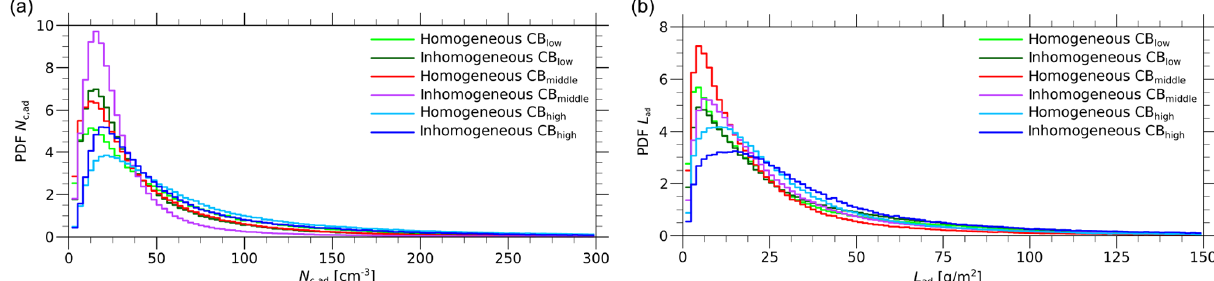
Figure 4. PDFs of the spatio-temporal distribution of 4 years (2007–2010) of MODIS retrievals as reported in the CCCM dataset at the 20km × 20km horizontal resolution at nadir below the A-Train satellite constellation, between 60 ◦ S and 60 ◦ N. Liquid clouds are selected. Light green – low, homogeneous clouds; dark green – low, heterogeneous clouds; red – middle, homogeneous clouds; purple – middle, heterogeneous clouds; light blue – high, homogeneous clouds; dark blue – high, heterogeneous clouds. (a) Droplet number concentration, N d (cm − 3 ); (b) liquid water path, L (gm − 2